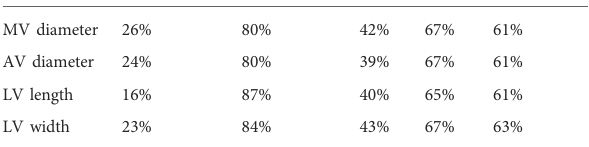
TABLE 5 Test diagnostics of CDH-speci fi c fetal left heart measurement using a threshold of z-score < − 1 for mortality prior to discharge from neonatal